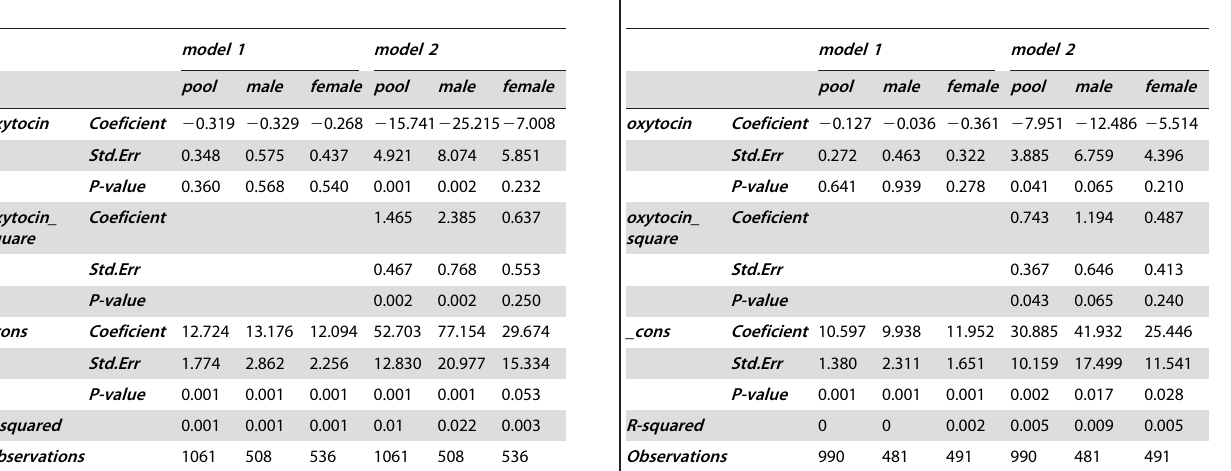
Table 2. Regression results for linear and nonlinear relationship between plasma oxytocin and